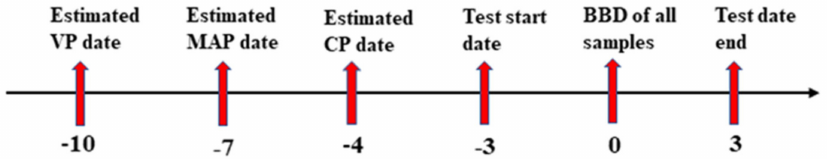
Figure 1. The estimated date of packaging of the beef steak samples and sampling time points for each of the packaging